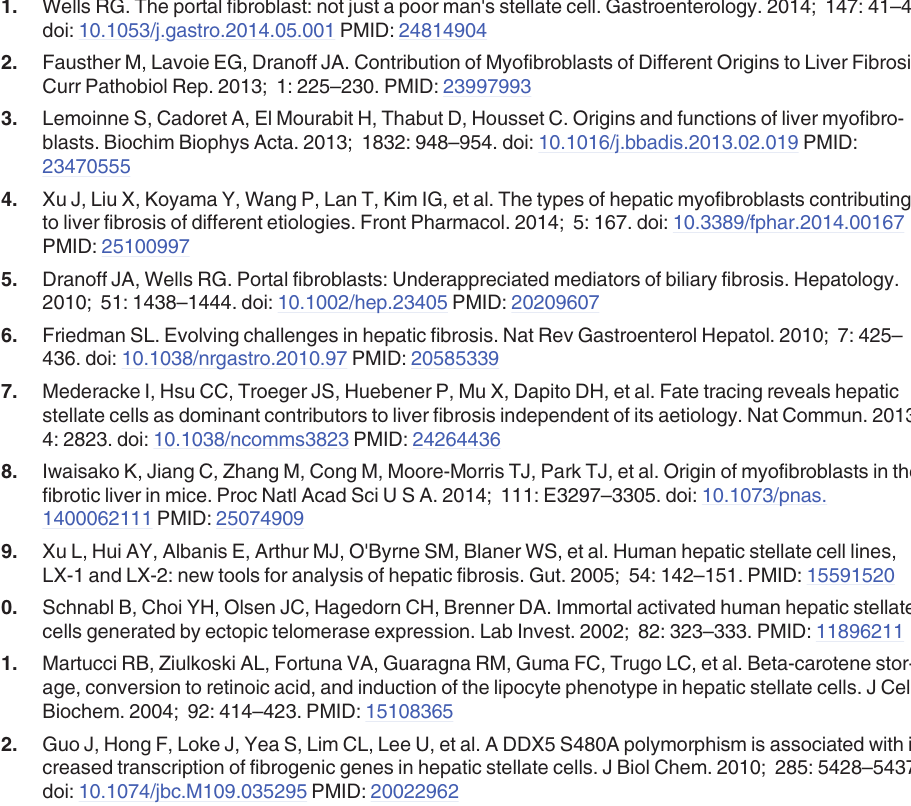
S1 Fig. Cultured primary isolated portal fibroblasts, and both immortalized RGF and RGF-N2 cells by phase contrast illumination microscopy. S2 Fig. Characterization of primary isolated portal fibroblasts by cell